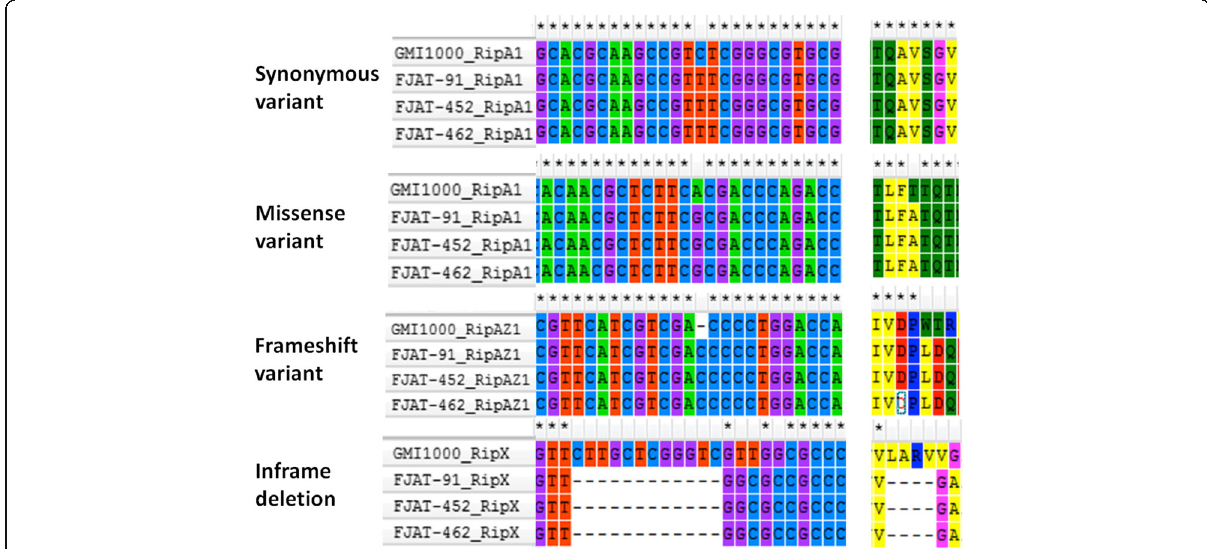
Fig. 5 Examples of shared sequence variations in ripA1 , ripAZ1 and ripX genes among three newly sequenced stains compared to the reference strain GMI1000. The right panel shows the resulting alterations in the amino acid sequences of the T3E